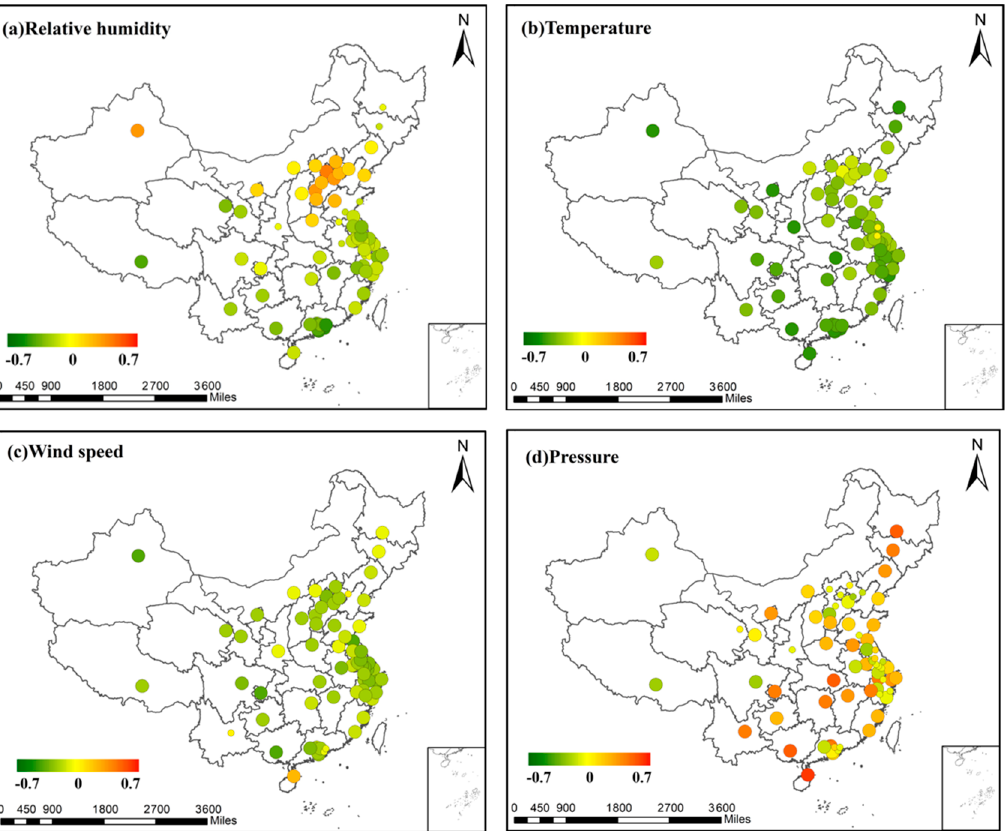
Figure 6. The correlation coefficient (r) values in the 68 major cities: ( a ) correlation between PM 2.5 concentration and RH; ( b ) correlation between PM 2.5 concentration and TEM; ( c ) correlation between PM 2.5 concentration and WS; and ( d ) correlation between PM 2.5 concentration and PS.